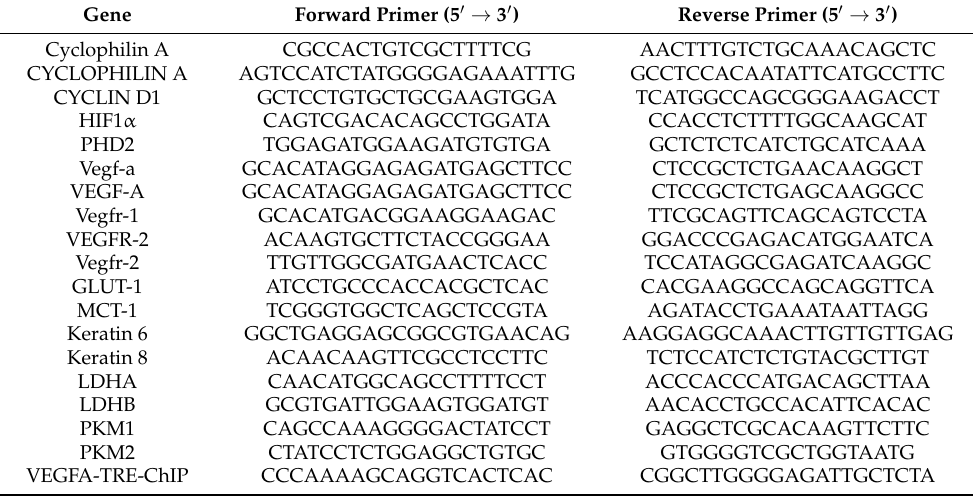
Table 1. Primers used for real-time PCR.